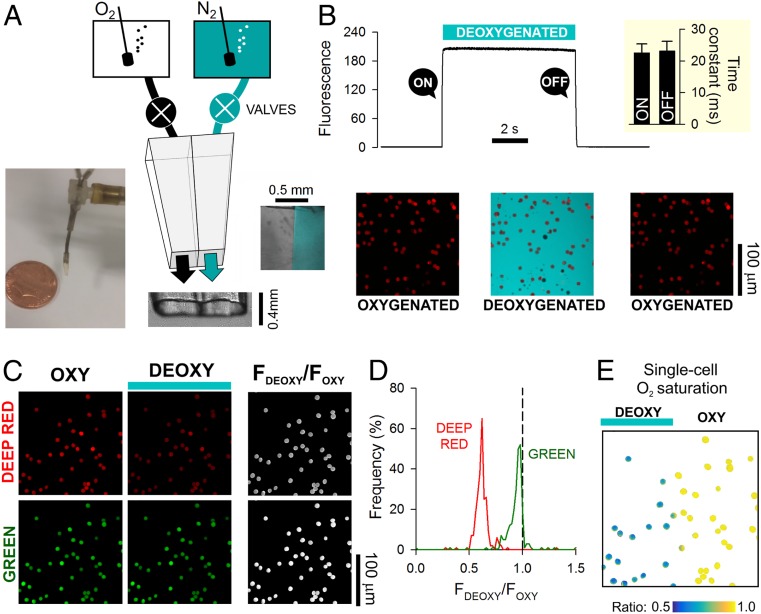
Measuring O2 exchange in RBCs using single-cell O2-saturating imaging. (A) Schematic of a dual microperfusion device loaded with oxygenated and deoxygenated solutions. Inset shows both microstreams released in parallel, one of which was labeled with 30 µM fluorescein. When flows are calibrated and balanced, microstreams become clearly separated. (B) Ultrarapid switching between the microstreams. Hypoxic microstream was labeled with 30 µM fluorescein. Rate of solution switching can be estimated from the fluorescence signal surrounding RBCs (wild type) loaded with CellTracker Deep-Red. Switching between solutions can be achieved with a time constant of 23 ms (Inset; n = 5). (C) Wild-type RBCs loaded with a mixture of Deep-Red and Green, showing fluorescence in oxygenated and deoxygenated microstreams. For these experiments, neither solution was fluorescently labeled. Grayscale ratio maps (Right) were calculated from these fluorescence maps (Left and Center). (D) On deoxygenation, Deep-Red fluorescence is reduced, whereas Green remains constant (wild-type RBCs; n = 356 cells). (E) Illustration of the method’s ability to resolve differences in O2 saturation. The field of view was split into oxygenated and deoxygenated halves by releasing both microstreams in parallel; only cells in the deoxygenated compartment showed a decrease in Deep-Red/Green ratio.